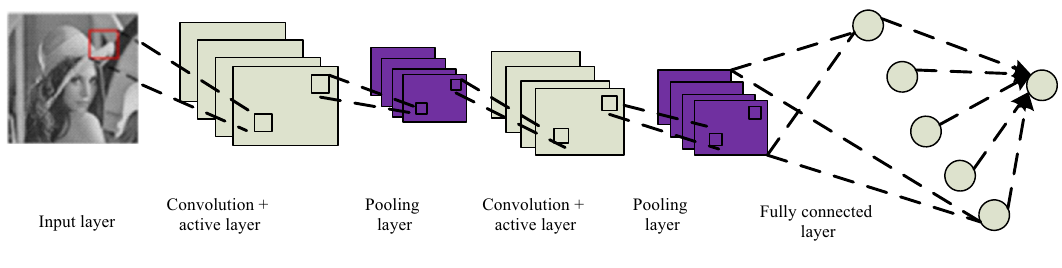
Figure 4: Structural characteristics of social networks.